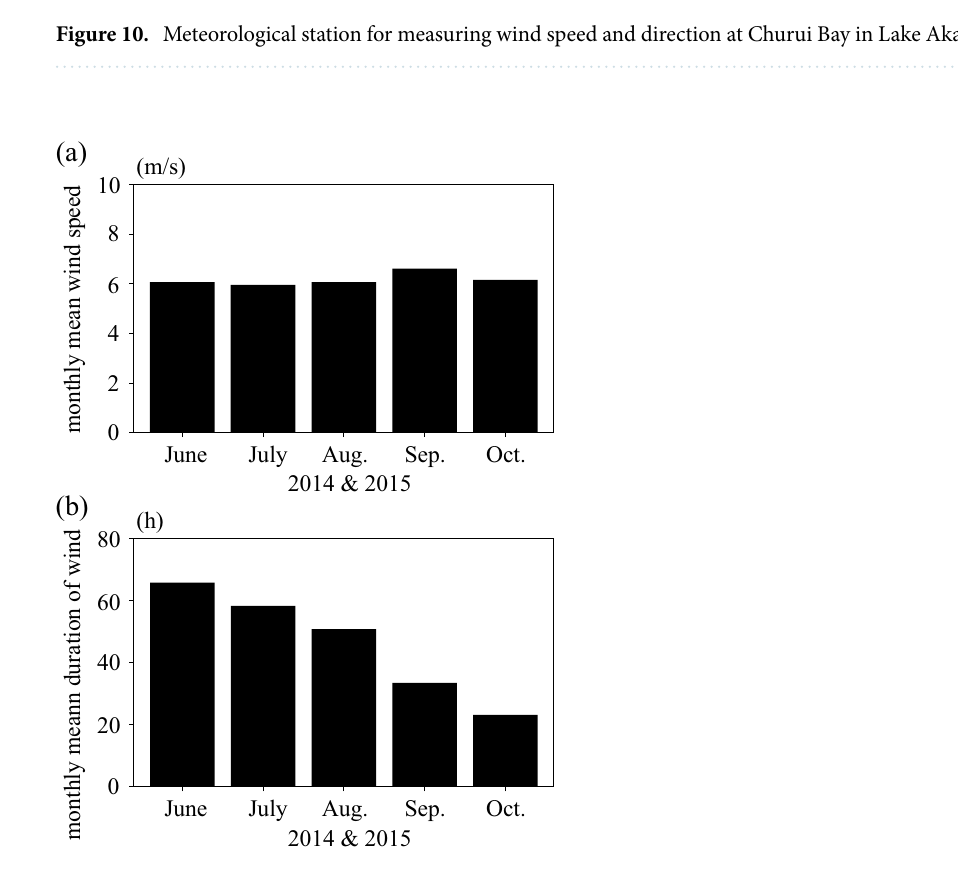
Figure 11. Wind speed and rotation of Marimo. ( a ) Monthly mean wind speed at Churui Bay in Lake Akan in 2014 and 2015. ( b ) Monthly mean duration of wind more than 4.8 m/s at Churui Bay in Lake Akan in 2014 and